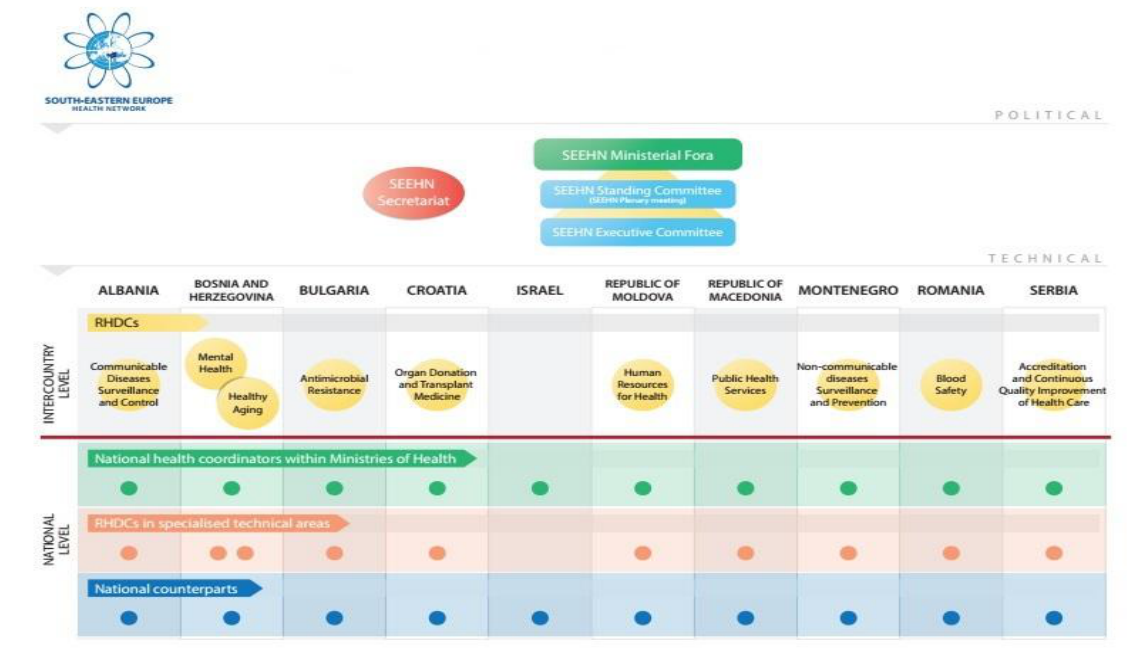
Figure 1. Governance of the SEE Health Network in